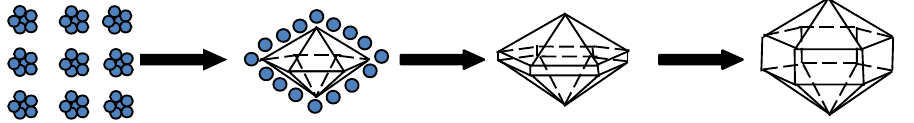
Figure 4. Illustration of the formation and evolution process of the β -NaYF 4 :Eu 3 + hexagonal prism bipyramids (redrawn under the written permission of Prof. Chunhua Lu [34]).